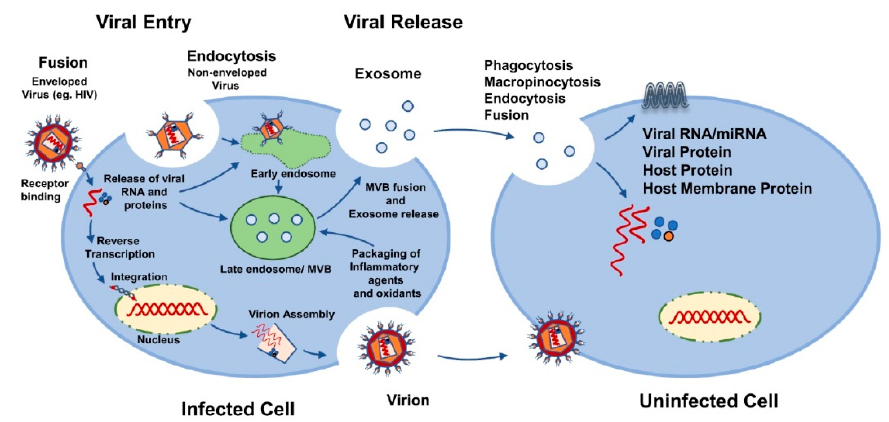
Figure 1. Possible mechanisms of viral spread using extracellular vesicles.